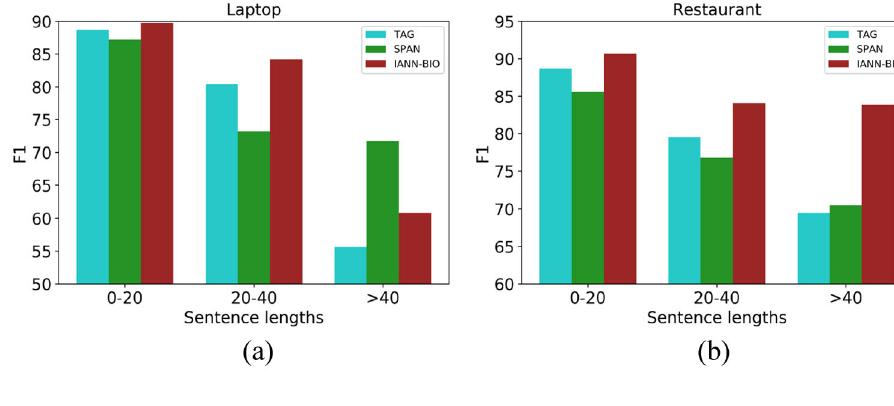
Fig. 12 F1 on laptop and restaurant w.r.t different aspect term lengths. a Reports the results in the laptop dataset, b reports the results in the restaurant